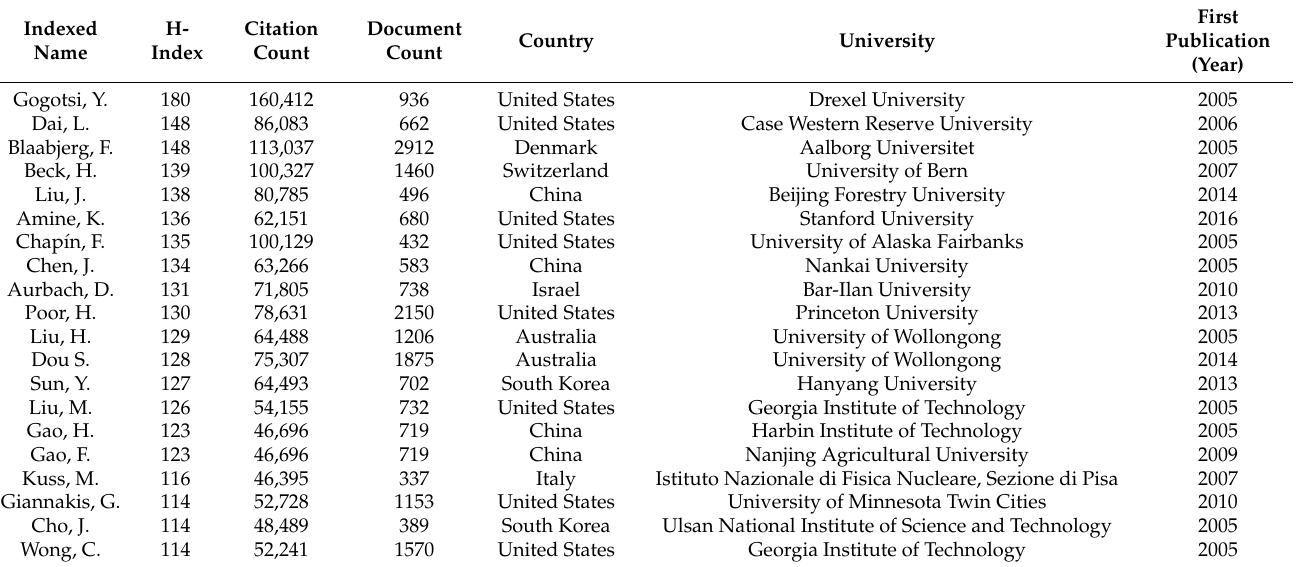
Table 1. Authors with h-index over 100 in EV